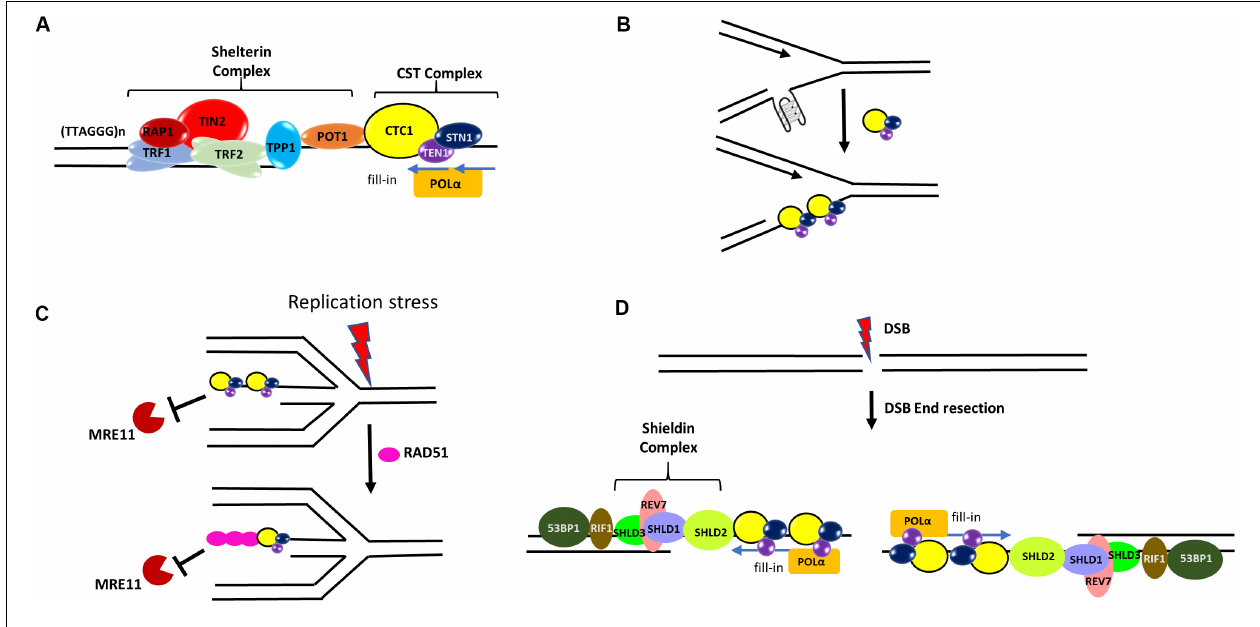
FIGURE 4 | Roles of CST in genome maintenance. (A) CST at telomeres. In human cells, CST complex interacts with the TPP1-POT1 subunit of shelterin and promotes efficient replication of telomeres. It also stimulates the C-strand fill-in activity of DNA polymerase α -primase (POL α ). (B) At elongating replication forks, CST may resolve or prevent the formation of G4s that hinder DNA replication. (C) During stalled forks, CST protects the reversed fork against MRE11 degradation by directly blocking MRE11 access to reversed forks and also facilitating the recruitment of RAD51 to forks. (D) During DSB repair, the Shieldin complex (SHLD1-SHLD2-SHLD3-REV7) localizes to DSB sites in a 53BP1- and RIF1-dependent manner. It has been hypothesized that CST may recruit POL α to DSB ends to fill in resected DSB ends.